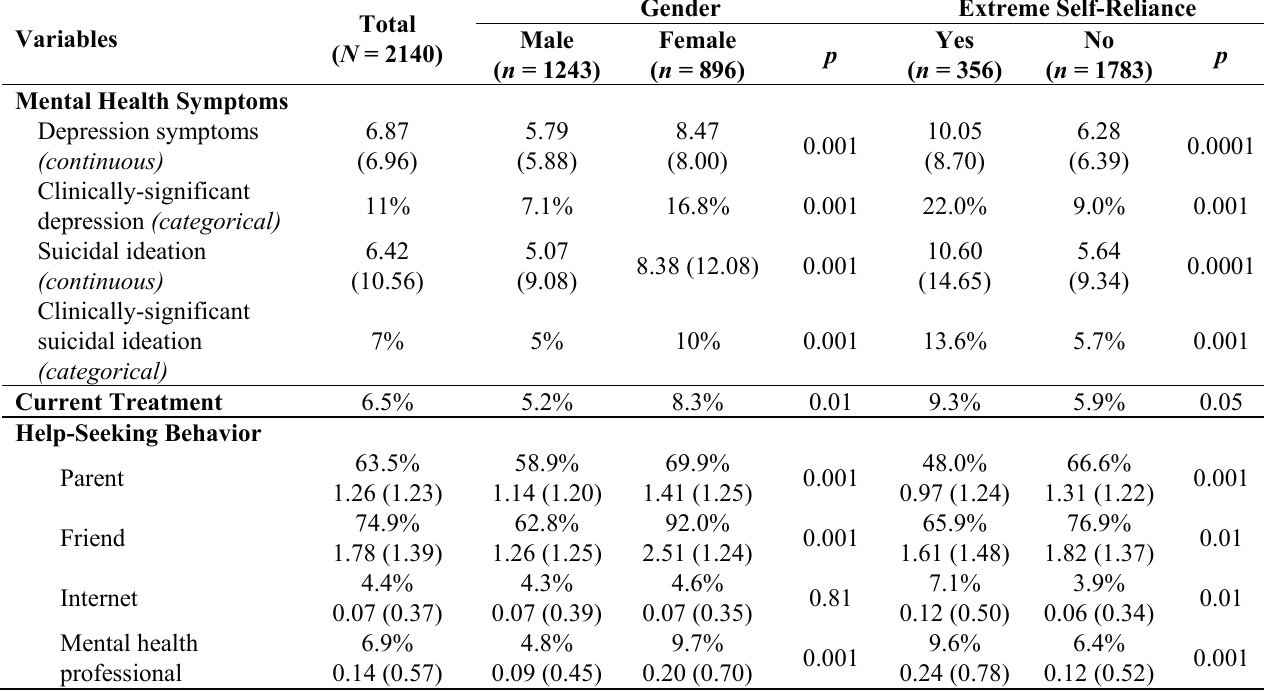
Table 1. Baseline mental health symptoms and help-seeking behavior of adolescents who did and did not endorse extreme